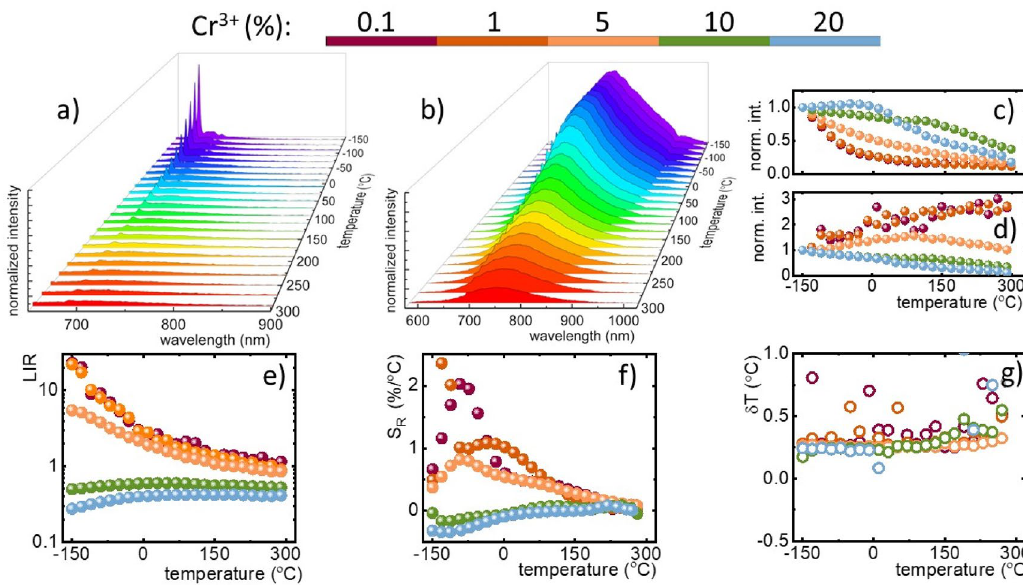
Figure 4. Thermal evolution of the YAl 3 (BO 3 ) 4 : 0.1%—( a ) and 20% Cr 3+ —( b ) emission spectra (λ exc 445 nm); representative thermal evolution of the integral emission intensity of Cr 3+ ions from 678–691 nm—( c ) and 800–830 nm—( d ) spectral ranges for YAl 3 (BO 3 ) 4 :Cr 3+ ; thermal evolution of LIR—( e ) with corresponding relative sensitivities (S R )—( f ) and uncertainties of temperature estimation (δT)—( g ) for YAl 3 (BO 3 ) 4 :Cr 3+